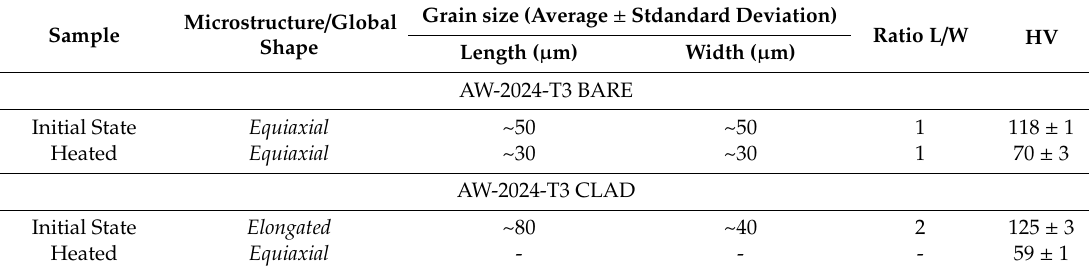
Figure 6. Microstructure of the AW-2024-T3 alloy after DCS measurements: ( a ) microstructure of bare AW-2024-T3 obtained by LM; ( b ) microstructure of bare AW-2024-T3 obtained by SEM; ( c ) microstructure of clad AW-2024-T3 obtained by LM; ( d ) microstructure of clad AW-2024-T3 obtained by SEM. Table 2. Grain size and hardness of AW-2024-T3 alloy.